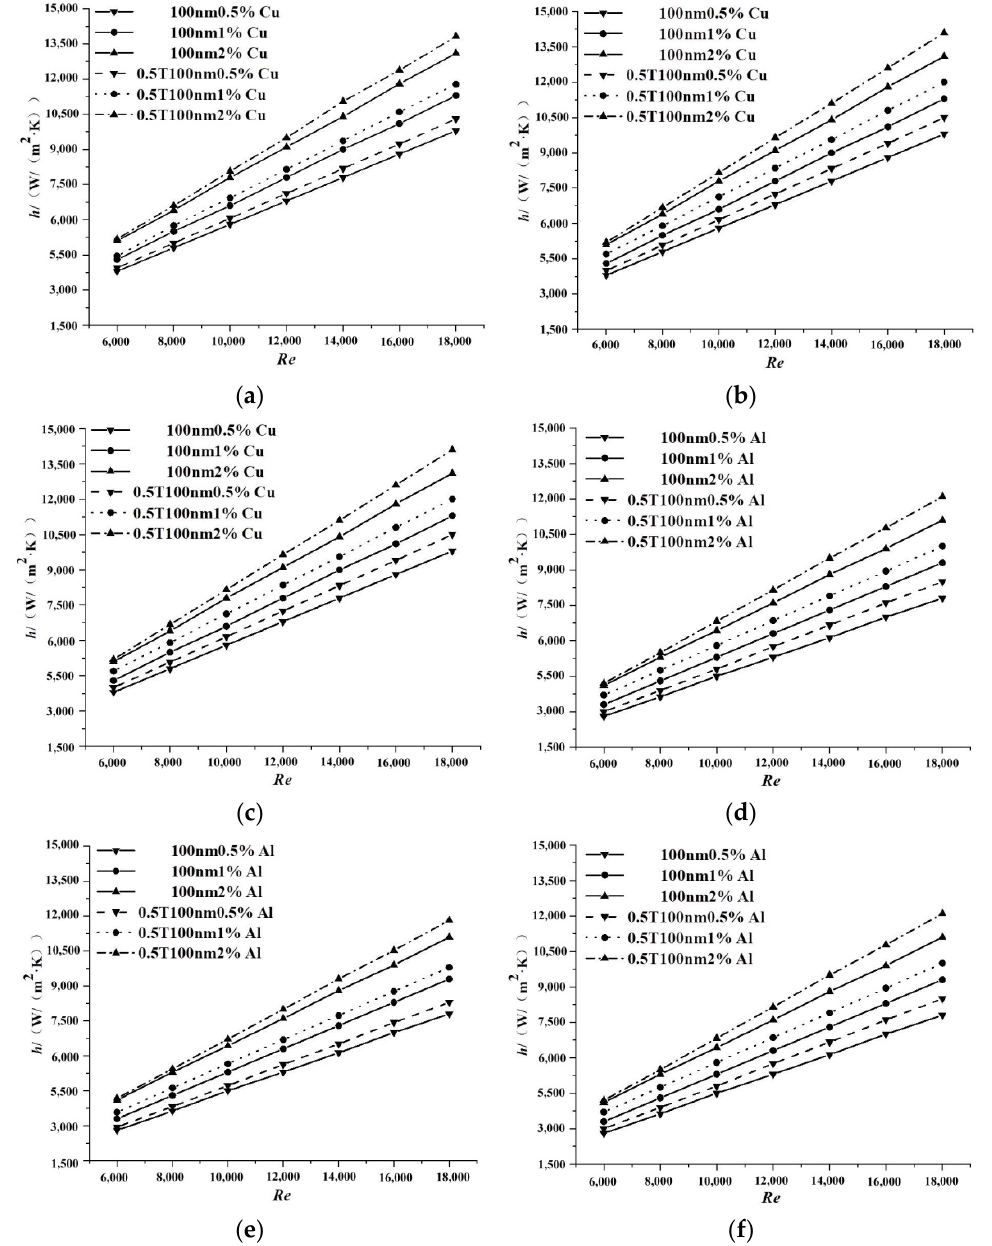
Figure 6. The heat transfer coefficients of Cu-H 2 O and Al-H 2 O nanofluids flow varied with different Reynolds numbers when the magnetic fields were applied along the X ( a , d ), Y ( b , e ), and Z ( c , f ) directions, respectively.